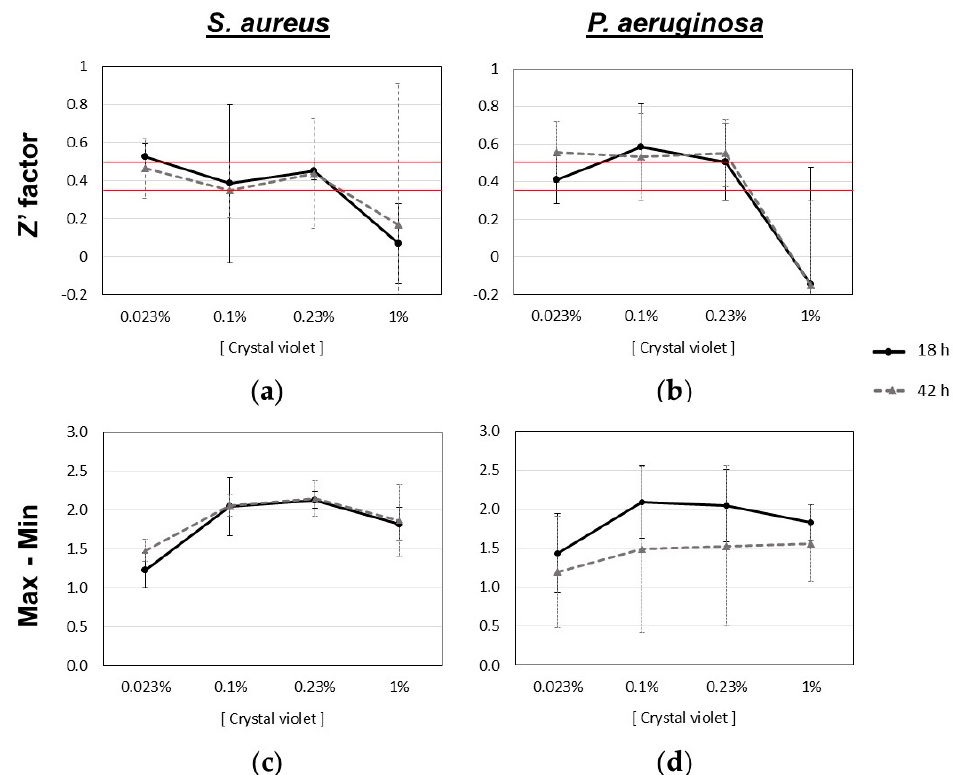
Figure 5. Effect of different crystal violet concentrations on the performance of a miniaturized biofilm screening assay in 384WP. Assay performance is measured using Z’ factor ( a , b ) and maximum minus minimum signal ( c , d ) of the crystal violet staining of S. aureus and P. aeruginosa biofilms grown for 18 h or 42 h in a volume of 40 µL with a concentration of the bacterial inoculum of 7.00 × 10 4 CFU mL − 1 ( S. aureus ) or 1.75 × 10 5 CFU mL − 1 ( P. aeruginosa ). Maximum minus minimum results are expressed in RAUs. Results are based on 3–5 independent biological replica experiments, with each plate containing from eight (one experiment) to 96 technical replicates and 12 to 32 media control replicates for each condition. The red lines in panels a and b represent the thresholds for determination of the quality of the assay: acceptable (Z = 0.35) and good (Z = 5).